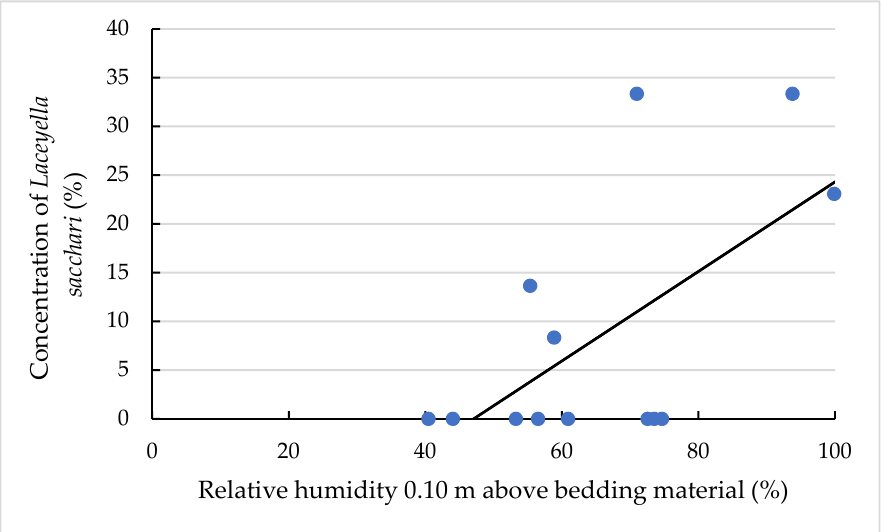
Figure 7. Concentration of Laceyella sacchari (%) in dependency of moisture content. The individual dots reflect the individual samples, and the black line is the regression line calculated with the equation written as: y = 0.46x − 21.61 and a coefficient of determination of 0.38. The tendencies for bedding temperature and bedding area per cow were shown for the occurrence of Aneurinibacillus thermoaerophilus ( p < 0.1). Interestingly, the obligate thermophilic bacterium Aneurinibacillus thermoaerophilus was found mainly in samples with a rather low bedding temperature (17.93 to 34.77 ◦ C). This is also shown by the negative regression coefficient of − 0.49 ± 0.22 (Table